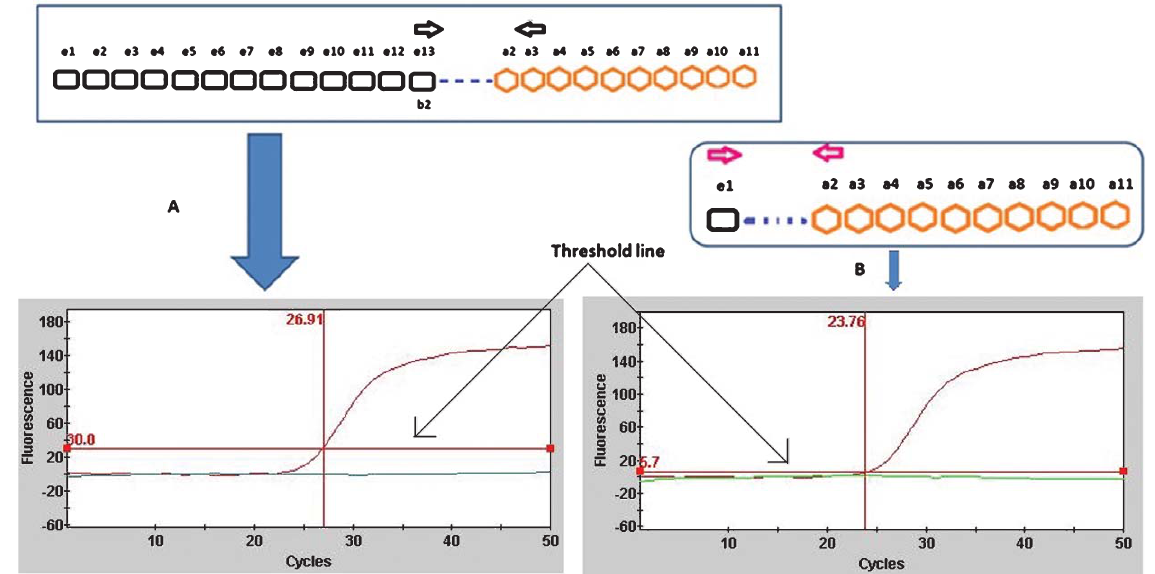
Fig.3. ReverseTranscription–RealTimePCRqualitativeanalysisoftheclinicalsampleusingtwoprimersetstargetingthecommonBCR-ABL breakpoints. A: PCR probes that detect e13a2 (b2a2) and e14a2 (b3a2) rearrangements within the Major Breakpoint Cluster Region (M-BCR). The corresponding real time PCR result show target signal below the threshold line while positive control (ABL gene target) generating a ‘S’ curve with Ct value between 20–30. B: PCR probe designed to detect e1a2 breakpoint within the minor Breakpoint Cluster Region. The corresponding real time PCR result is similar to that shown for ‘A’ with the target signal running below threshold line while the positive control (ABL gene target) showing a Ct value between 20–25. In both ‘A’ and ‘B’, the signal is negative indicating that the translocation breakpoints targeted in both these reactions were not